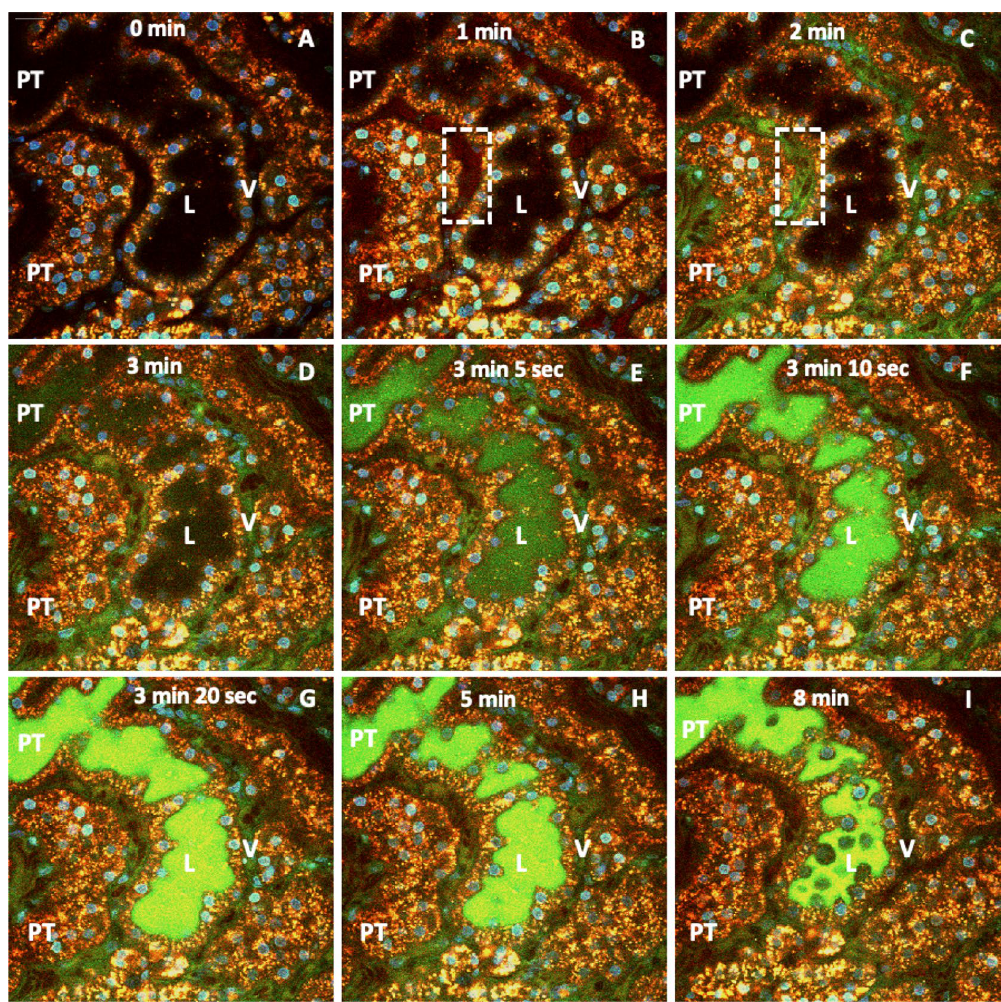
Figure 5. Time-lapse images outline disruptions to normal renal filtrative and endocytic capacities that resulted from severe IRI. Intravital two-photon micrographs were taken with a 60× objective from a live rat in group 4, which received HGD and was subjected to IRI. After reinstating blood flow to the kidney, we observed a substantial injury 24 h after reperfusion. At that time point, we infused a mixture of 4-kDa FITC and 150-kDa TRITC dextrans, along with Hoechst 33342, via the jugular vein of the animal, to track renal dynamics. ( A – I ) illustrate the loss of EGFP-actin expression, reductions in the thicknesses of the vasculature (V), aggregated red blood cells (rouleaux) in the peritubular capillaries (dashed line in D ), absence of endocytic uptake of low-molecular-weight FITC dextran molecules by the proximal tubules, and simultaneous entry of both FITC and TRITC dyes in the lumen. Moreover, these images illustrate the initial presence of the TRITC dye entering the peritubular vasculature ( B ) and then the entry of the FITC dye ( C ). After that, there was a reduced level of fluorescence within the vasculature observed in image I. Scale bar represents 20 µm. The time-lapse video for this event is presented in Supplemental Video